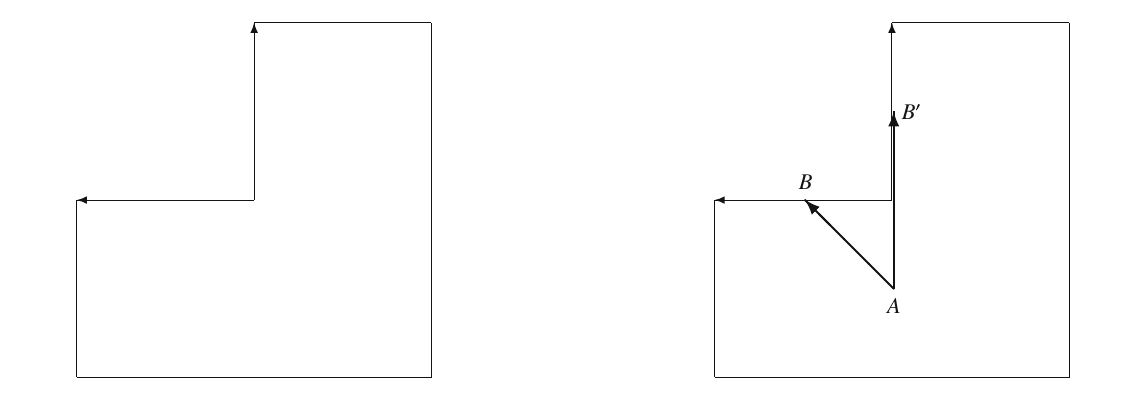
< 1. We identify two 4 > 1. We identify two 4